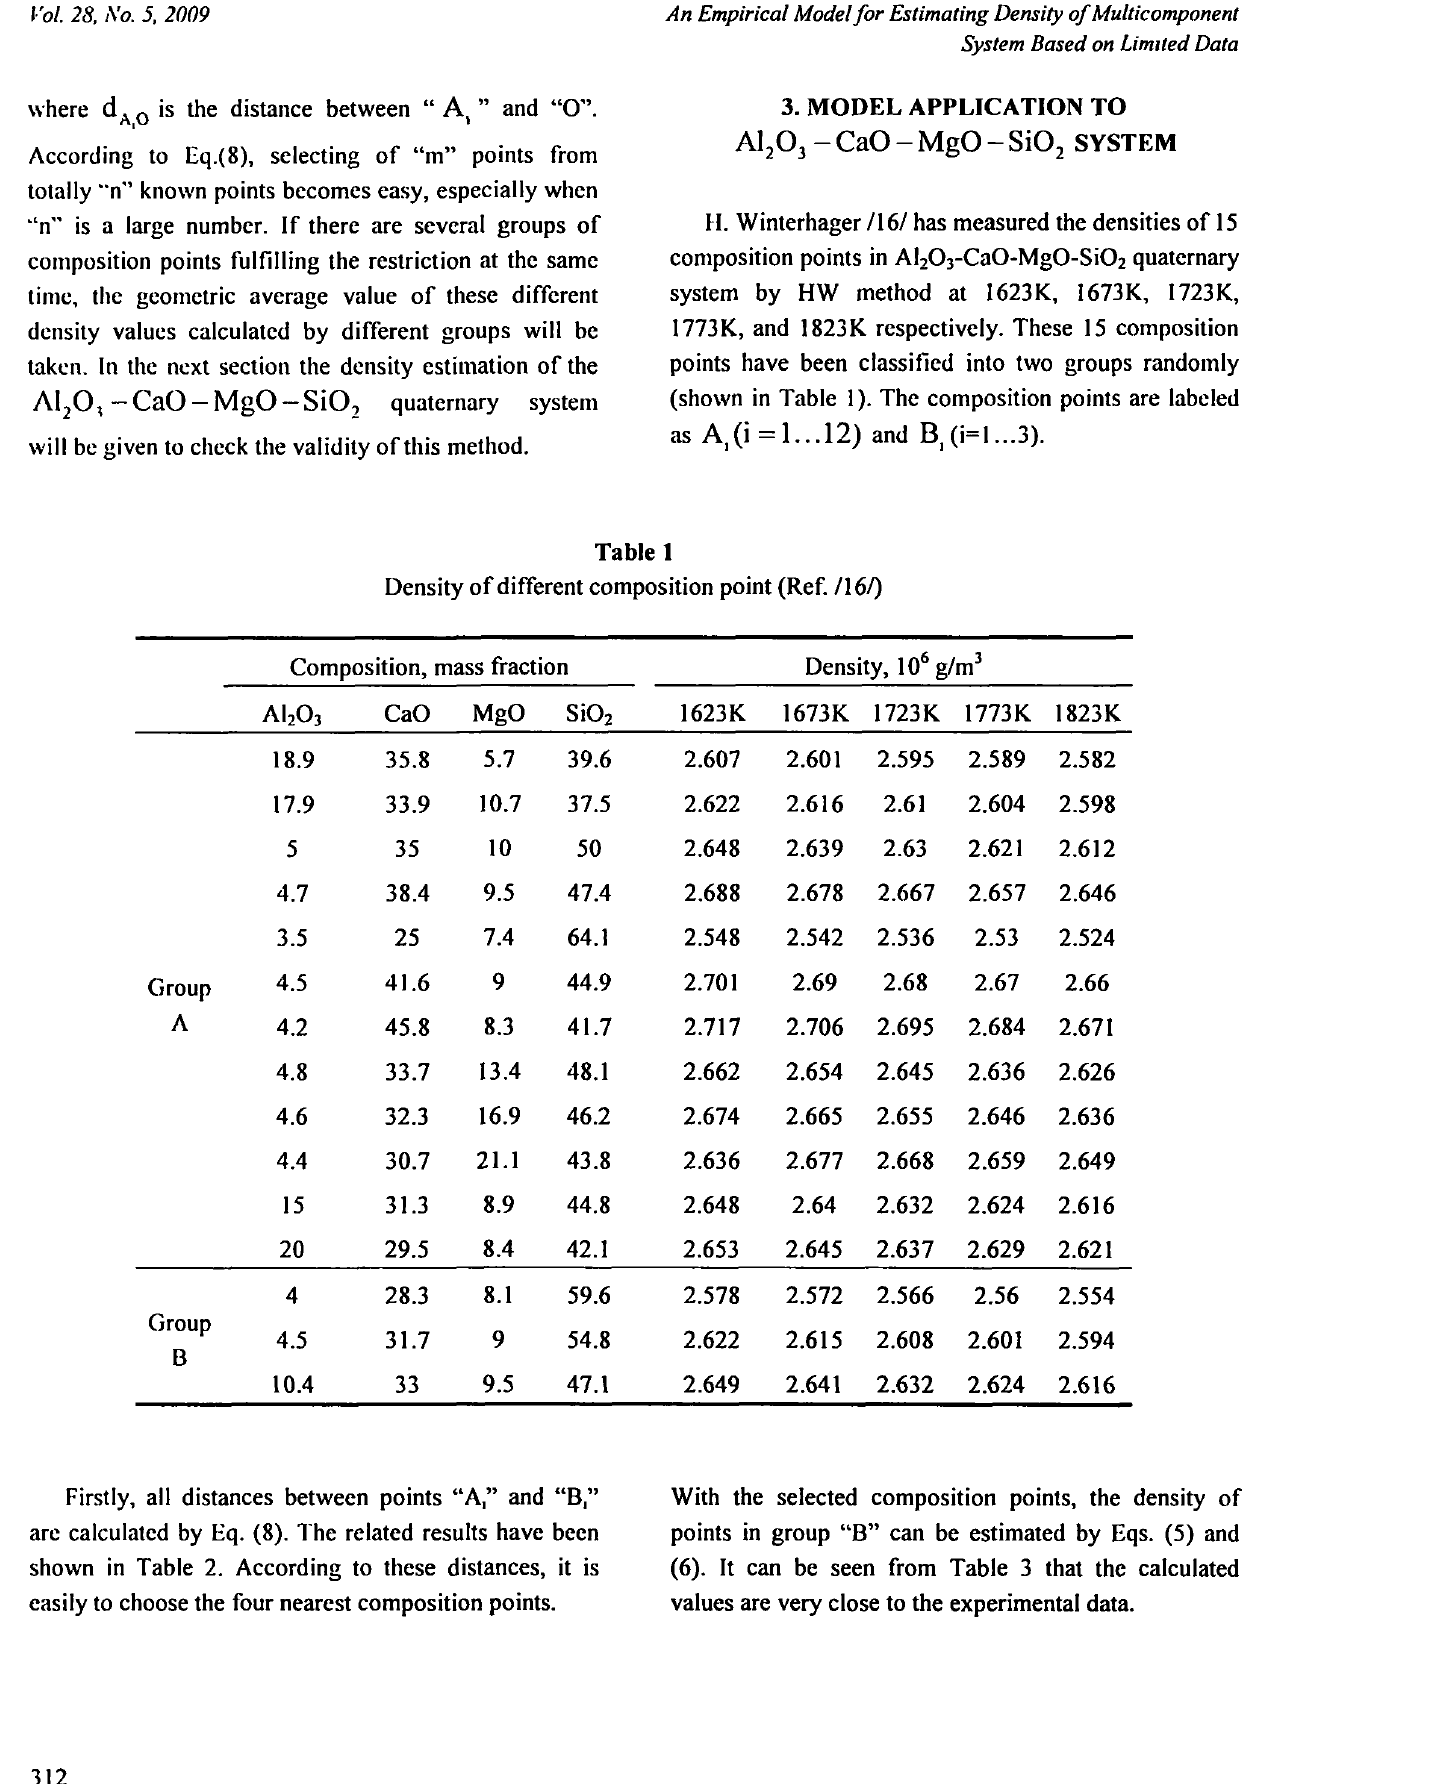
Density of different composition point (Ref.